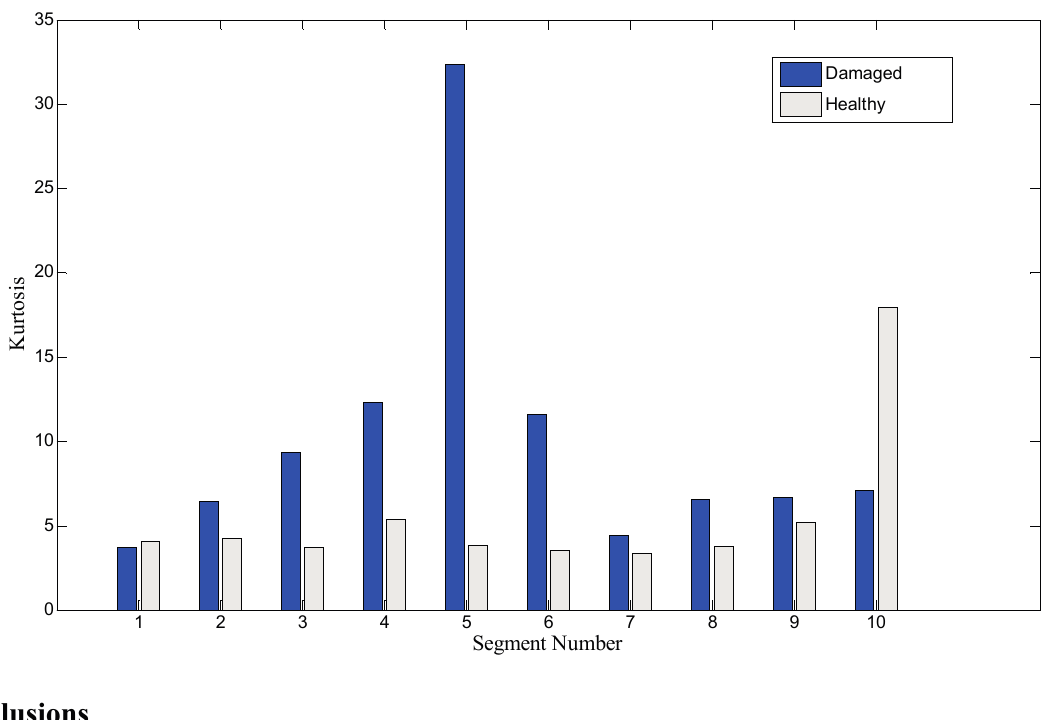
Figure 15. Kurtosis value of 10 segments (additional test